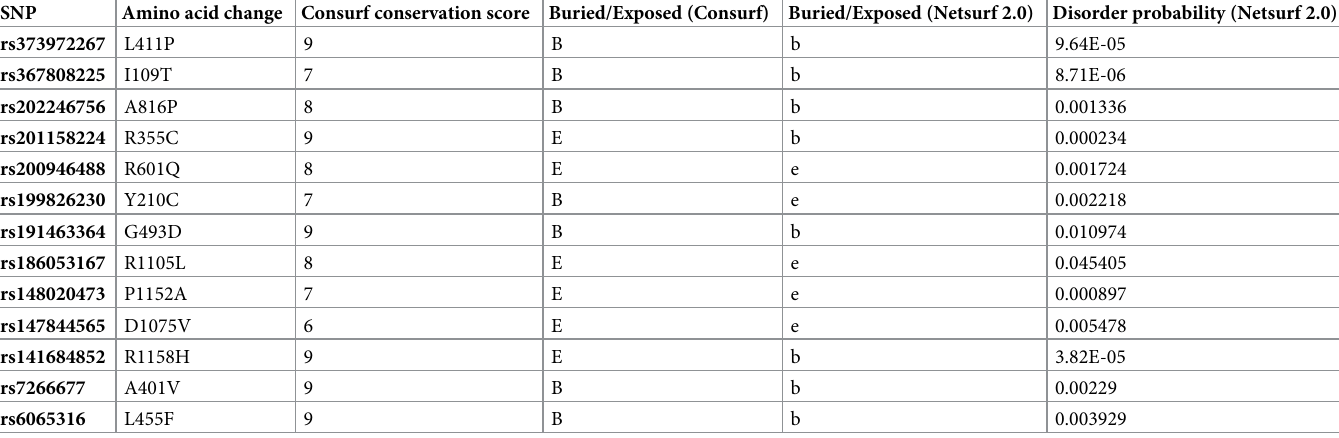
b: Buried; e: Exposed.